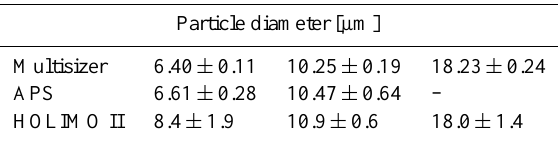
Table 2. Comparison of the sizing of monodisperse polystyrene la- tex spheres. The standard deviation of the APS and HOLIMO II measurements were derived by a Gaussian fit to the normalized data. Multisizer data were provided by the